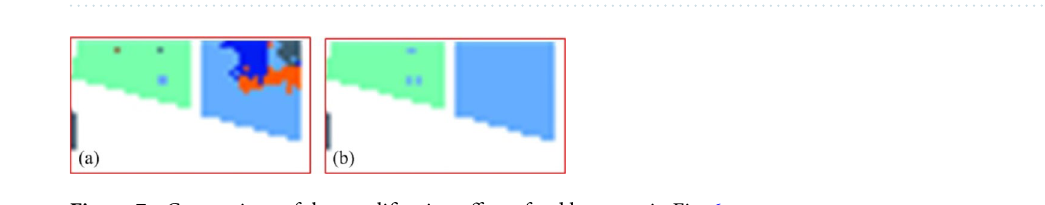
Figure 7. Comparison of the amplification effect of red box area in Fig. 6a.